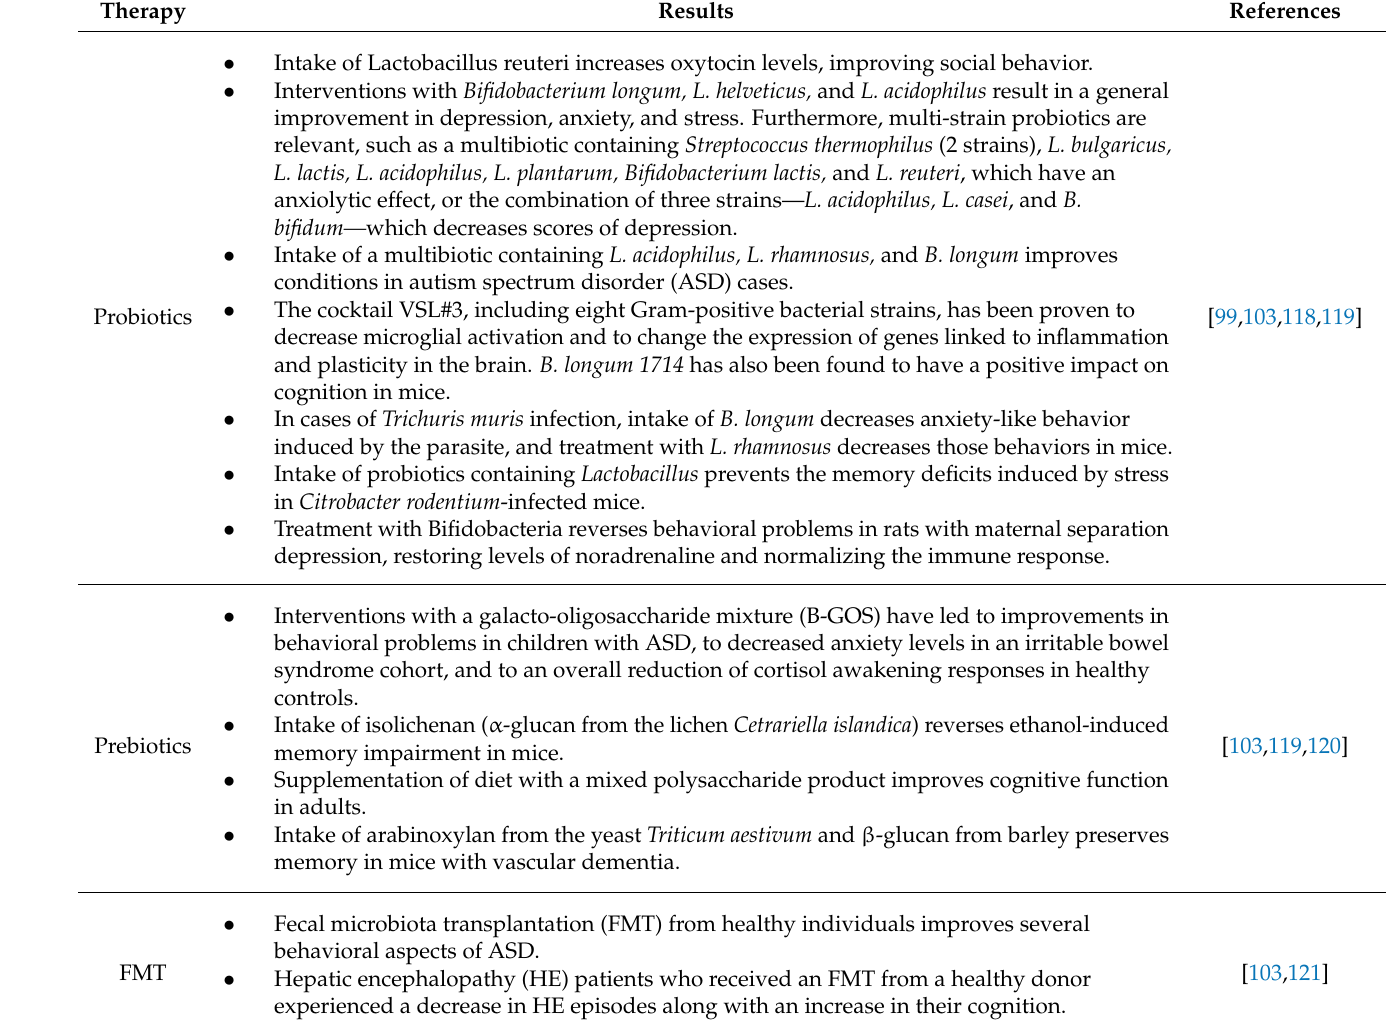
Table 1. Summary of the impact of different types of psychobiotics [41] on cognitive, emotional, and neural variables. Therapy